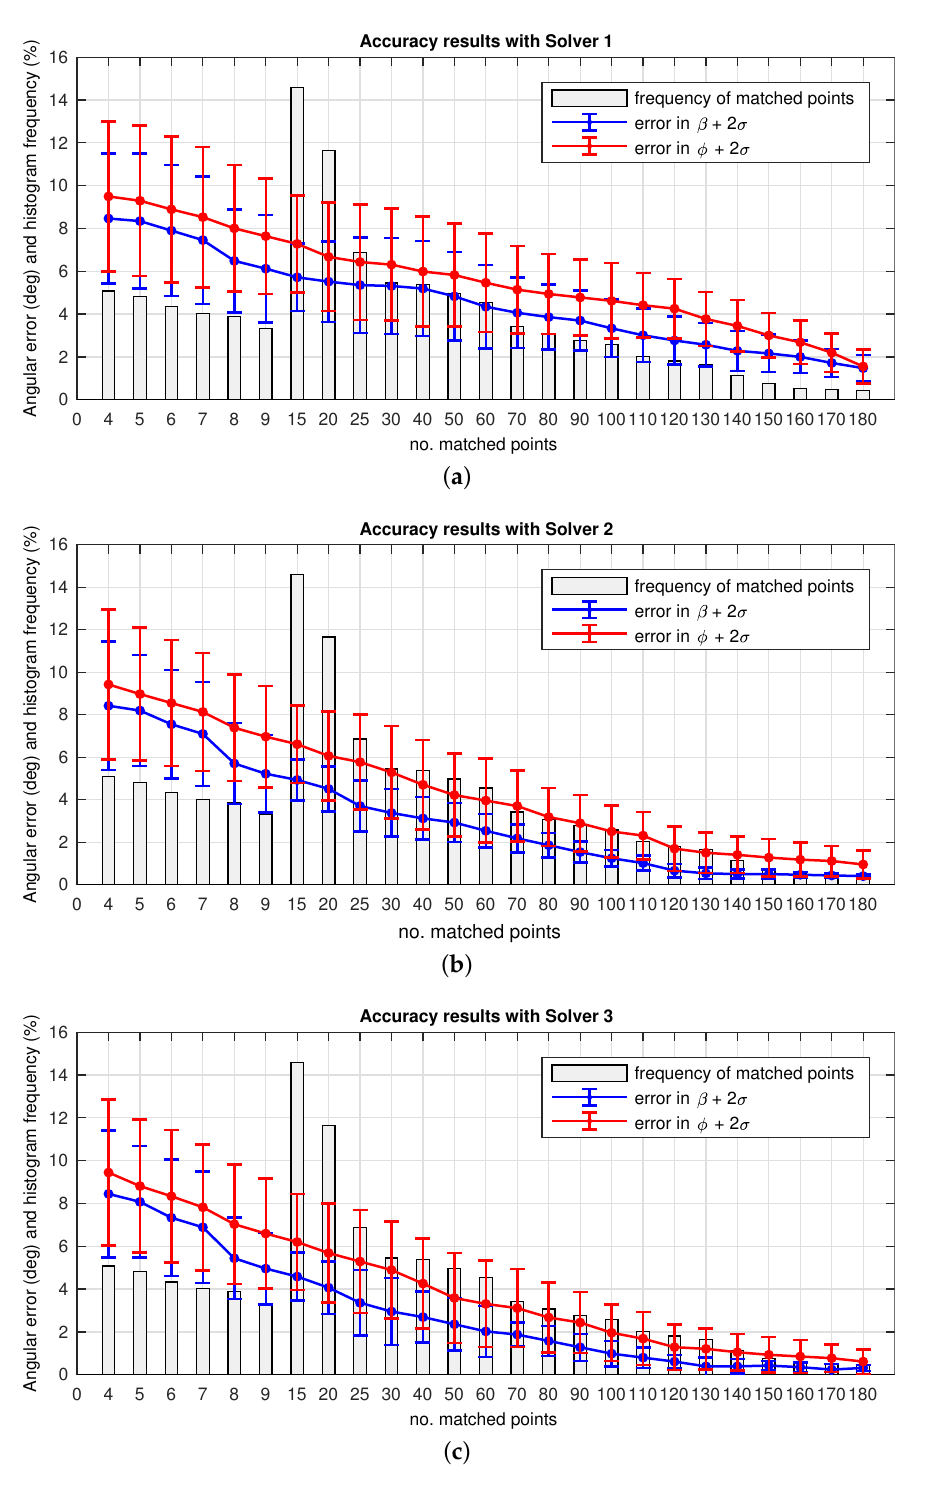
Figure 16. Omnidirectional odometry accuracy as the error in ( β , φ ) versus the number of matched points. ( a ) Solver 1; ( b ) Solver 2; ( c ) Solver 3. The bins represent subdivisions for the number of matched points detected. The frequency of repetition is presented as % out of the